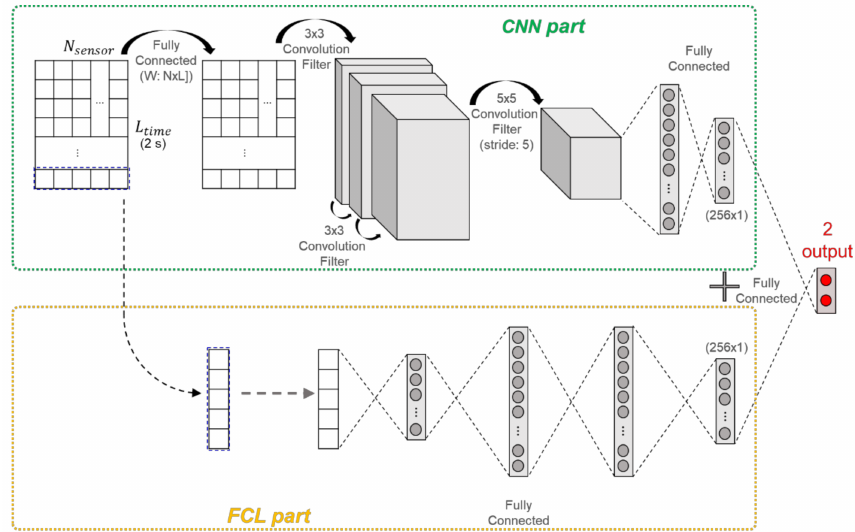
Figure 2. Neural network